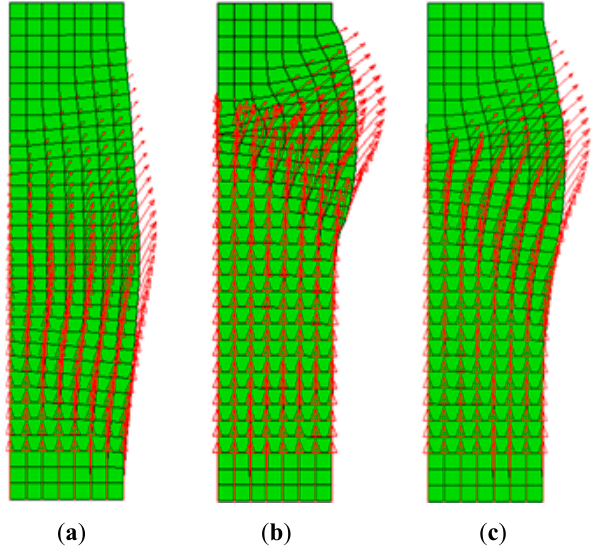
Figure 17. Displacement vector fields of layered models ( a ) layered_hom ( b ) layered_het ( c ) layered_het_transition.